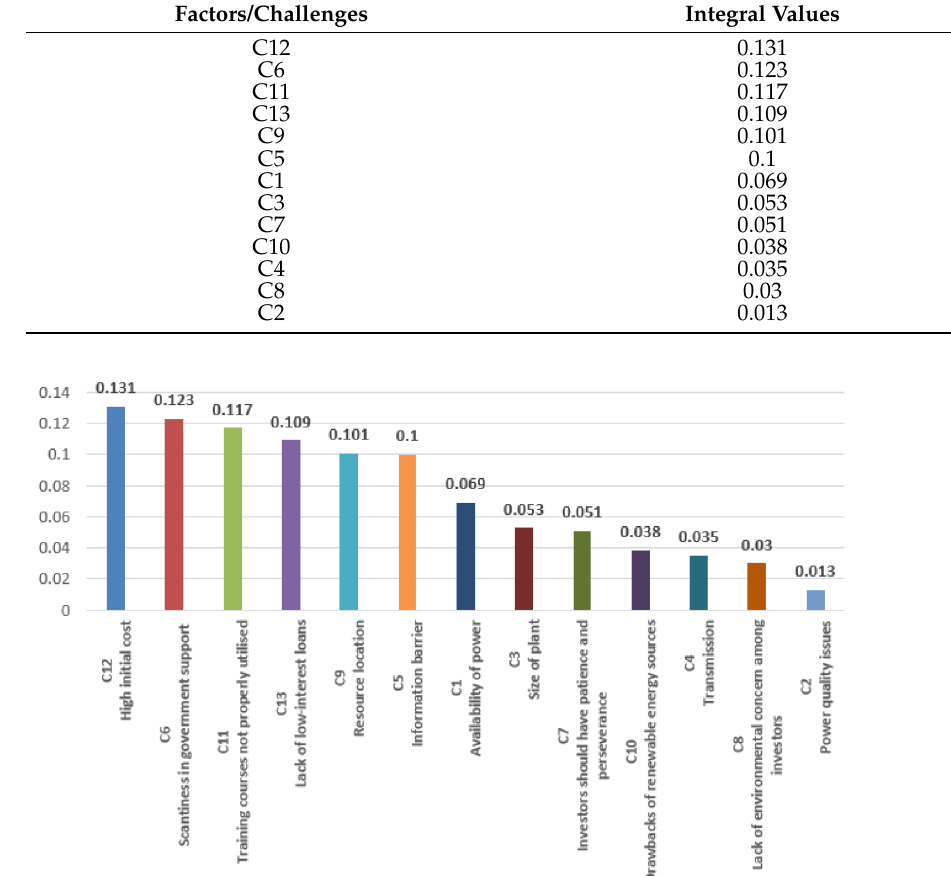
Table 3. Integral values of factors/challenges considered.